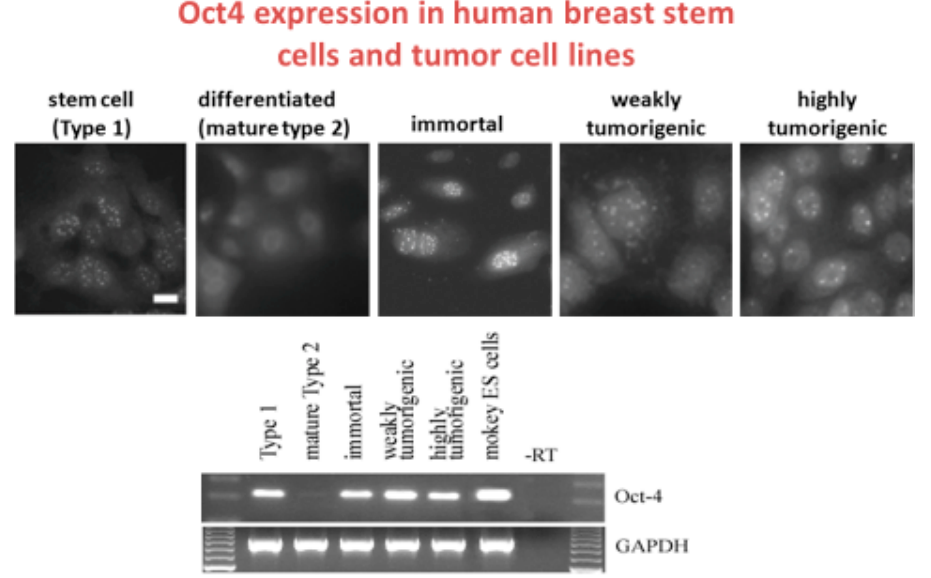
Figure 2. The composite of these two figures illustrates that the clonally- derived normal human adult breast stem cells express Oct4A (Type 1), via immune-histochemical use of fluorescent antibodies to Oct4A in the normal breast stem cells, but not in the differentiated breast cells (Type 2), are still expressed in SV40 immortalized normal breast stem cells, which are not tumorigenic, are still expressed in irradiated and weakly tumorigenic breast stem cells and are expressed in the neu/ErB-2 highly transformed clone. The Type 2 cells were differentiated normal human breast stem cells. The reverse transcription polymerase chain reaction data are correlated with the immuno-histochemical data of Oct4A in this series of human breast adult stem cells. No expression of Oct4 was seen in Type II differentiated cells (lane 2) but Oct4A was still expressed in the immortalized, weakly and highly tumorigenic cells. Monkey ES cells were used as a positive control (lane 6). Lane 7 is a no template control. While the GJIC data were not shown here, the normal breast adult stem cells (Type 1), immortalized, weakly and highly tumorigenic cells have no functional GJIC, as measured by the fluorescent scrape loading/dye transfer technique, whereas the Type 2 cells had functional GJIC. Type 2 or differentiated Type 1 cells were derived from Type 1 or adult human breast stem cells after the Type 1 cells had been exposed to cholera toxin [114]. Scale bars: For Type 1 to highly tumorigenic